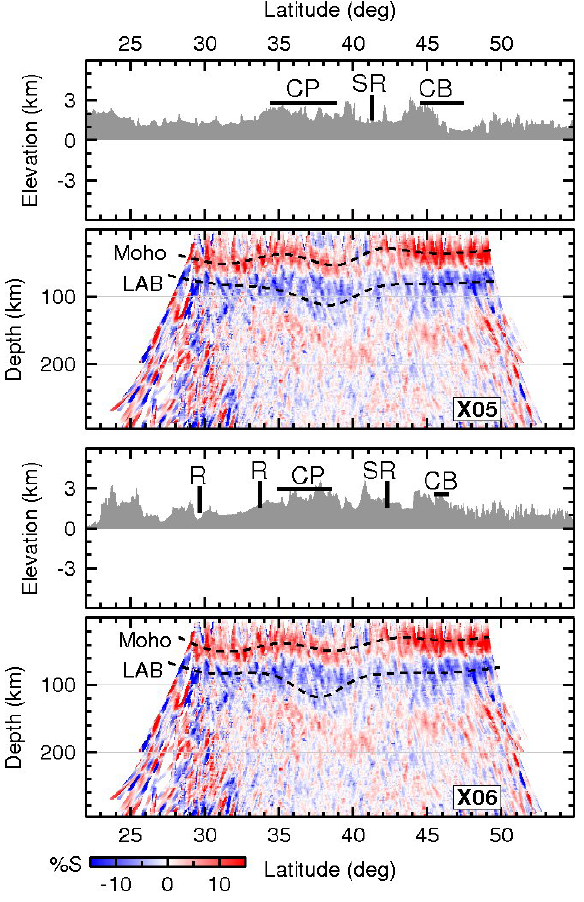
Fig. 15. Migrated S receiver functions along profiles X05 and X06 as in Fig.